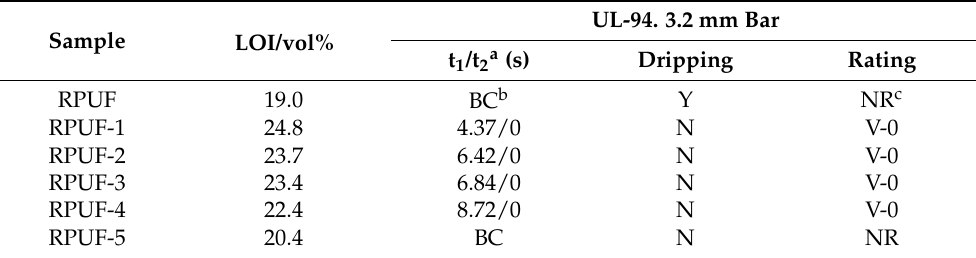
Table 2. LOI, UL-94 data for RPUF and RPUF-R